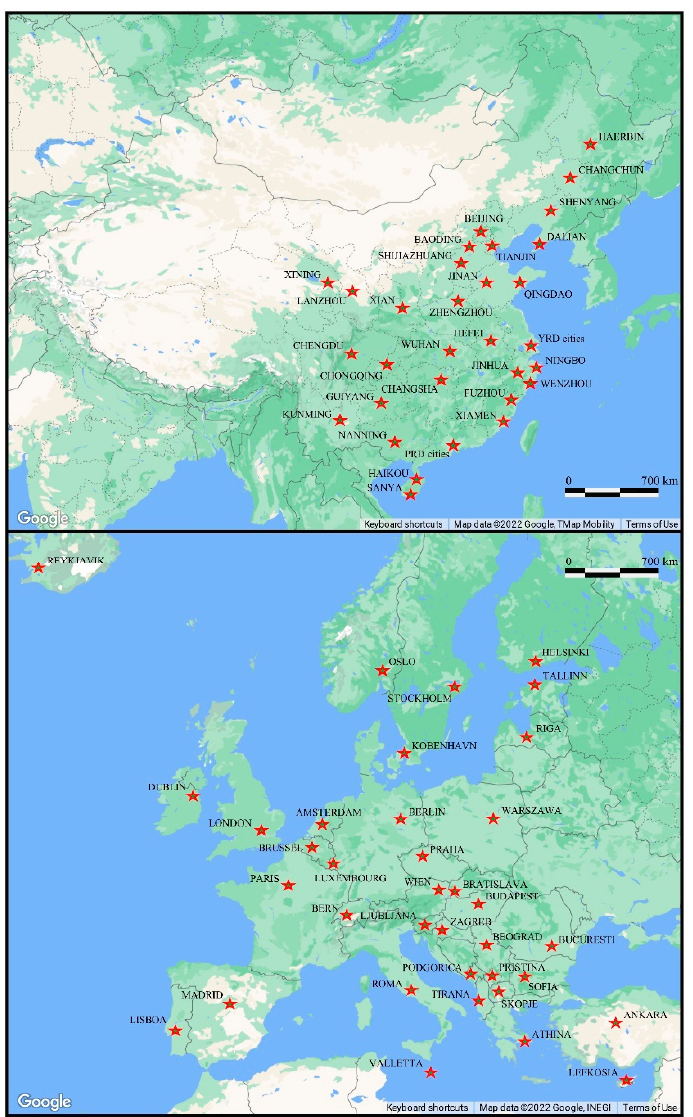
Figure 1. Locations of selected cities in China and Europe. In China, YRD (Yangtze River Delta) cities include Shanghai, Nanjing, Jiaxing, Shaoxing, Hangzhou, Suzhou, and Wuxi. PRD (Pearl River Delta) cities include Guangzhou, Shenzhen, Dongguan, Huizhou, Foshan, and Zhuhai.